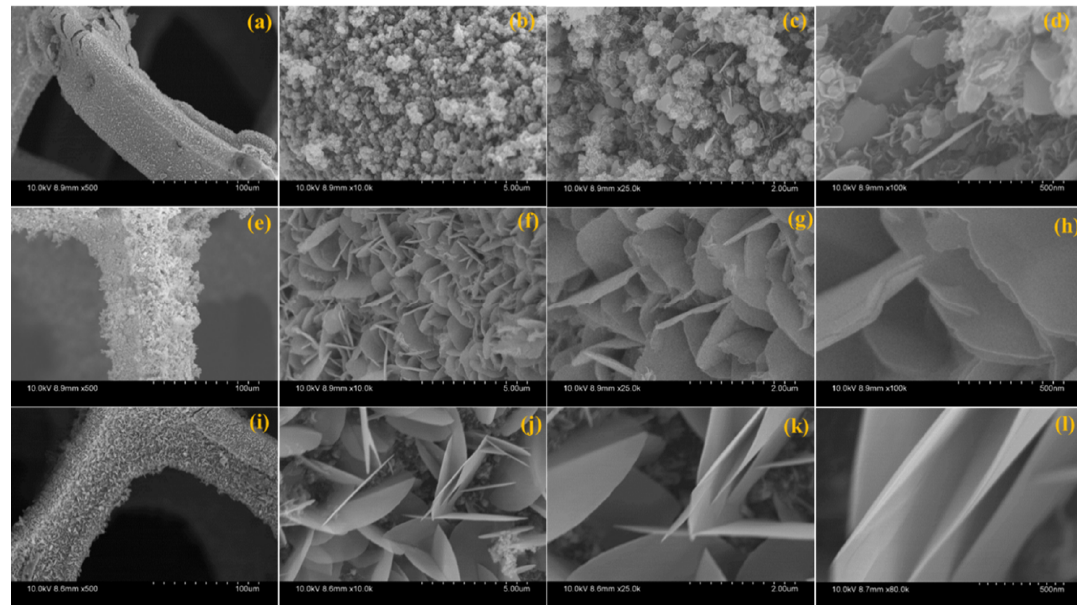
Figure 2. Scanning electron micrographs of MnFe-9 ( a – d ), CoFe-12 ( e – h ), and CoFe-24 ( i – l ) at different magnifications.